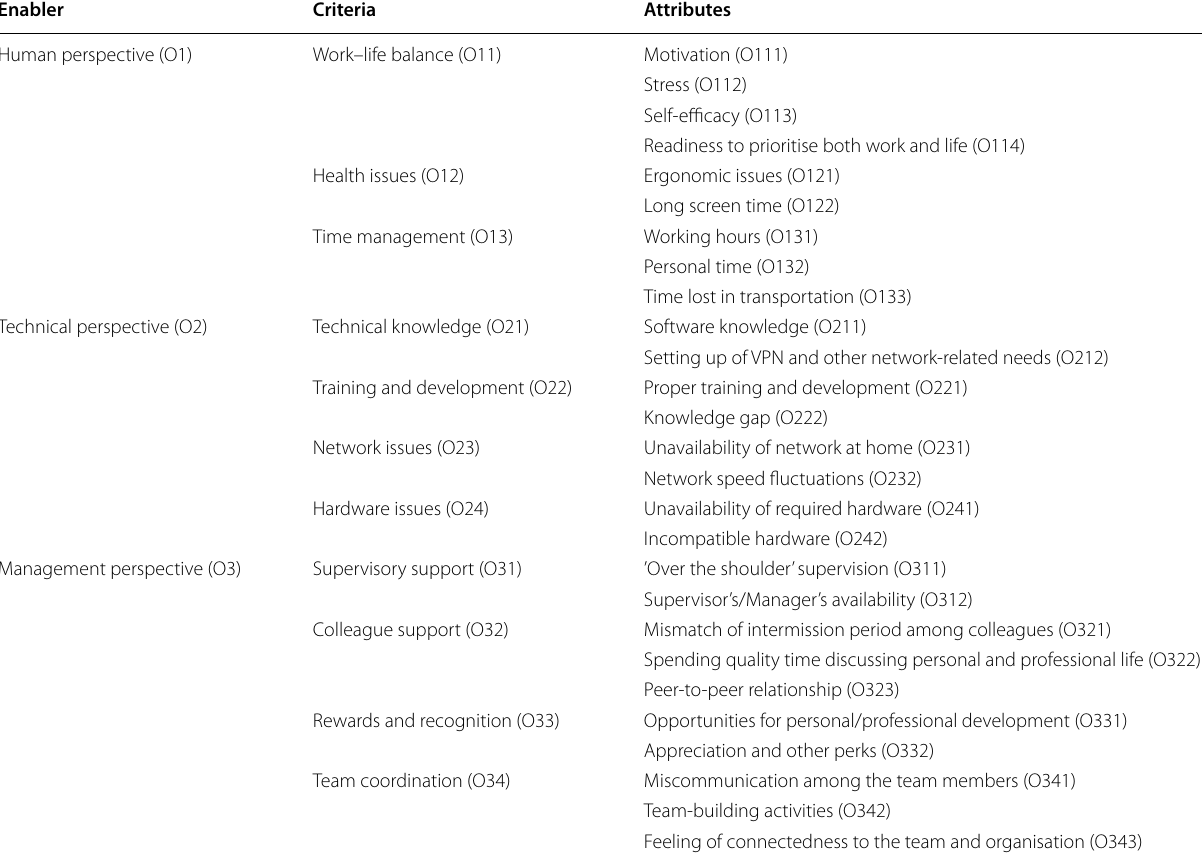
Table 1 Conceptual model for work-from-home for software professionals Enabler